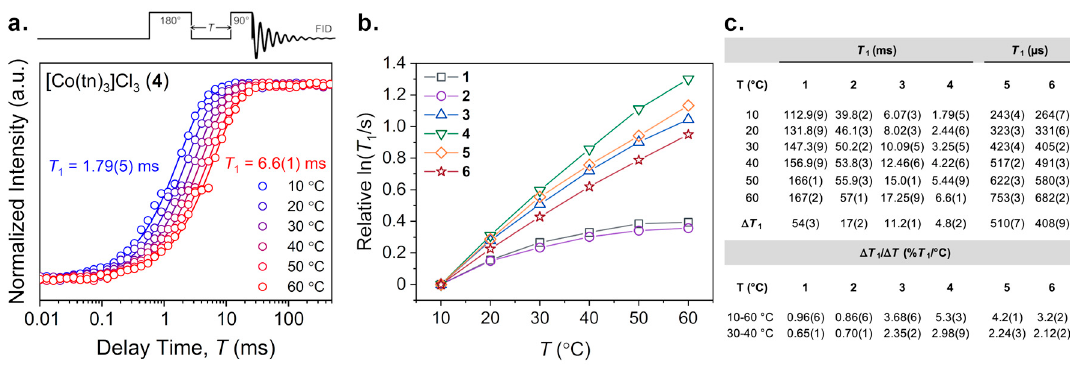
Figure 2. ( a ) Experimental variable-temperature (10–60 ◦ C) inversion recovery measurements (circles) with exponential recovery fits (traces) for [Co(tn) 3 ]Cl 3 ( 4 ) on logarithmic scale. Temperature-specific T 1 values were extracted from exponential decay fits. The general pulse sequence for the inversion recovery experiment is depicted. ( b ) Variable-temperature T 1 plots of 1 – 6 on logarithmic scale showing relative changes. Error bars are within the width of the data points. Traces are guides for the eye. ( c ) Temperature-specific T 1 spin–lattice relaxation times with error for 1 – 6 from 10–60 ◦ C with absolute values of ∆ T 1 and relative values of ∆ T 1 / ∆ T temperature sensitivities.